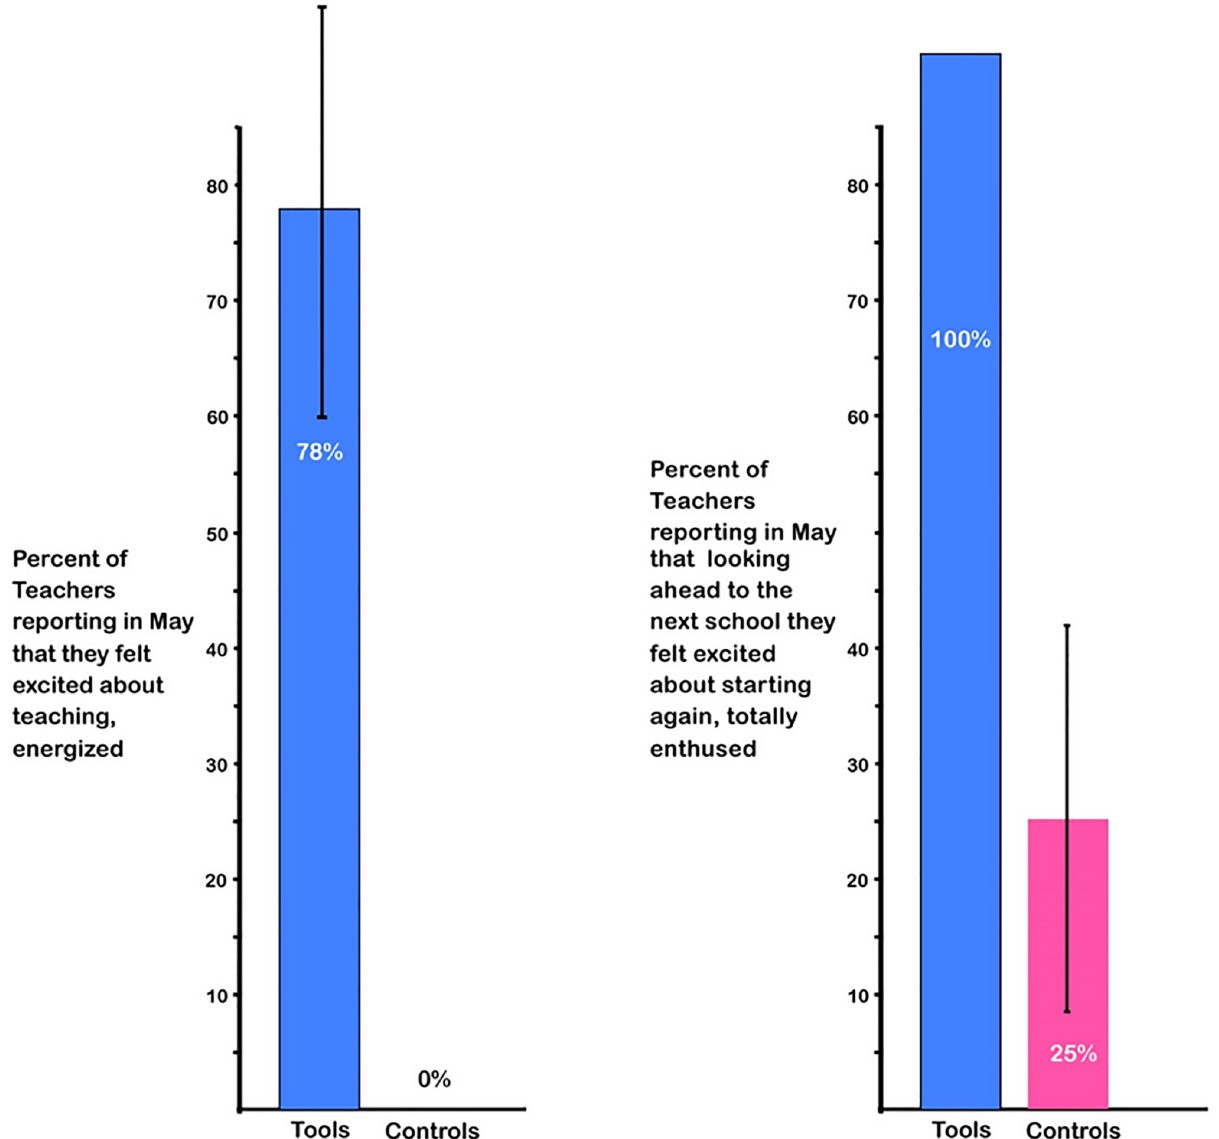
Fig 7. Teachers’ feelings about Teaching. Over three-quarters of Tools teachers, but none of the control teachers, responded in May that they were extremely excited about teaching (choices 1 or 2 on the 10-point scale): χ 2 (1, N = 18) = 4.99, p = 0.02, odds ratio = 3.58. Similarly, all Tools teachers responded that they were utterly enthused and looking forward to the next school year (choices 1 or 2 on the 10-point scale), while only 2 control teachers selected choice 2: χ 2 (1, N = 18) = 5.67, p < 0.02, odds ratio =